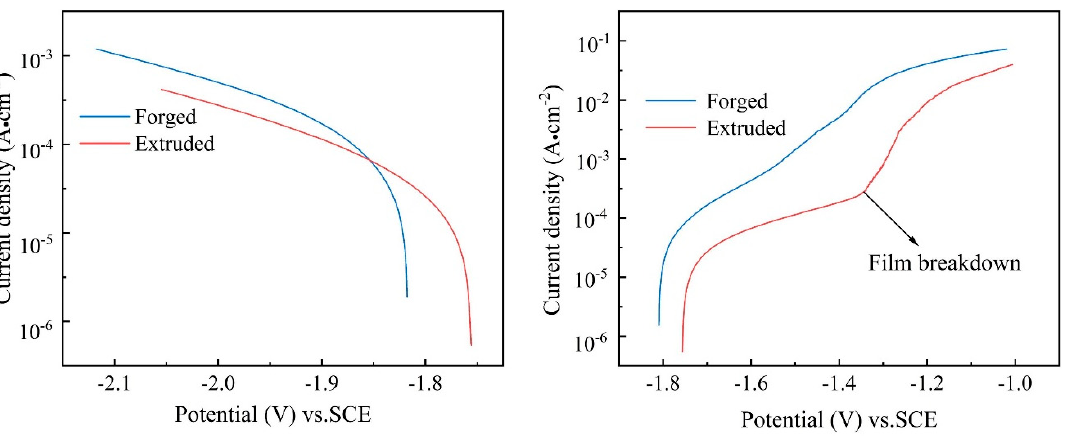
Figure 12. Comparison of polarization curves of extruded and forged WE43 alloys in 0.6 M NaCl solution: ( a ) cathodic side; ( b ) anodic side.